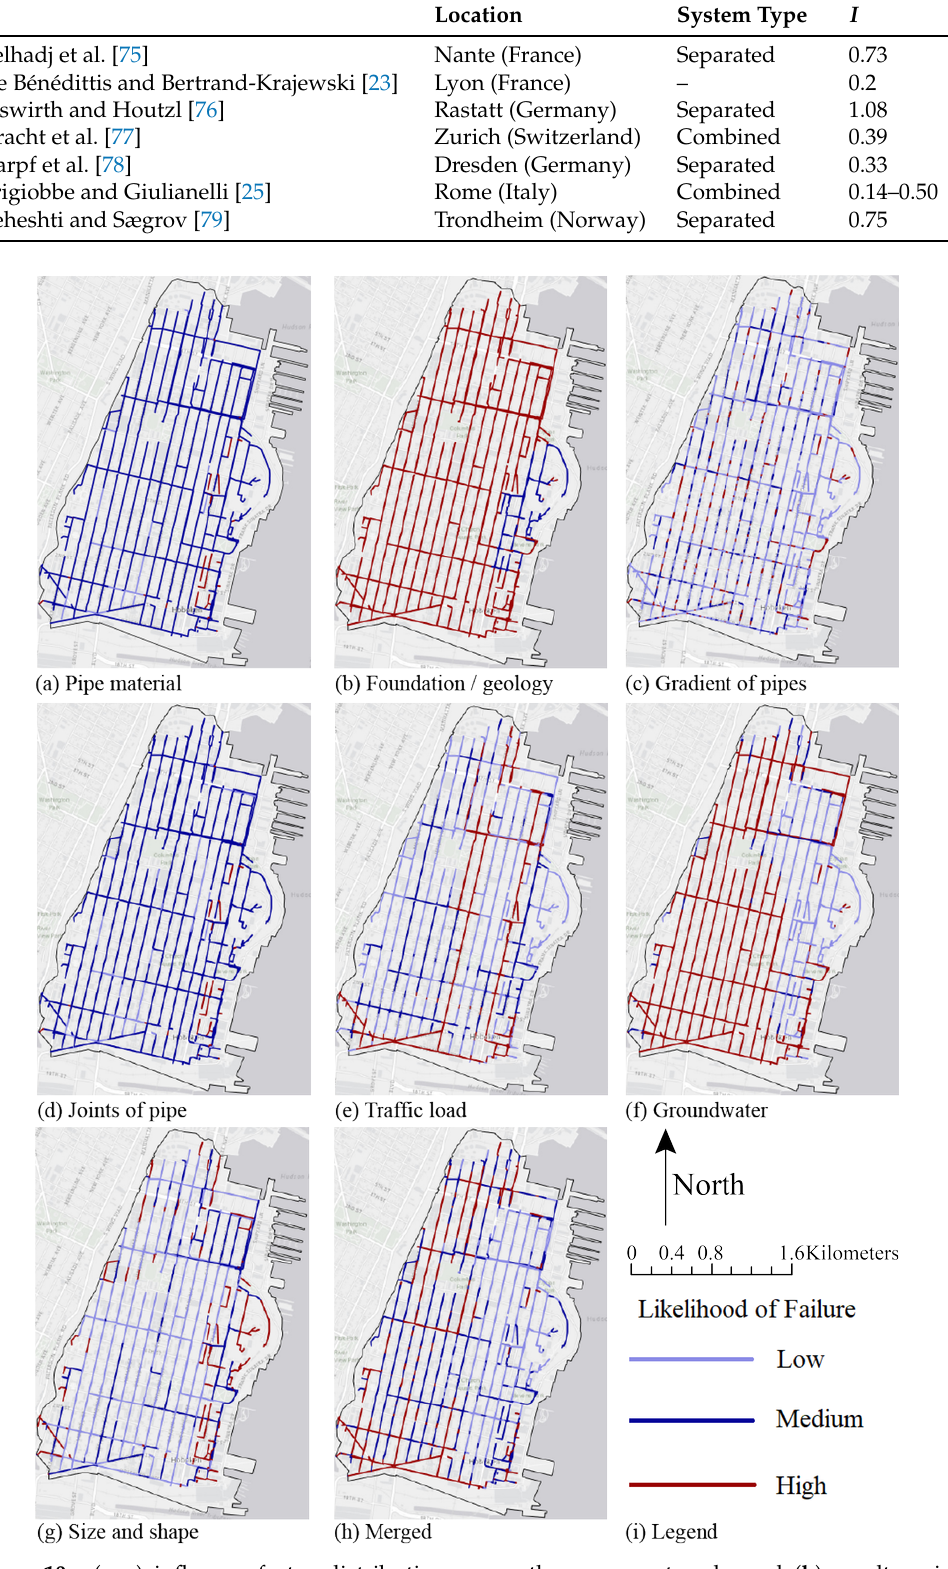
Figure 10. ( a – g ) influence factor distribution across the sewer network; and ( h ) results using Equation